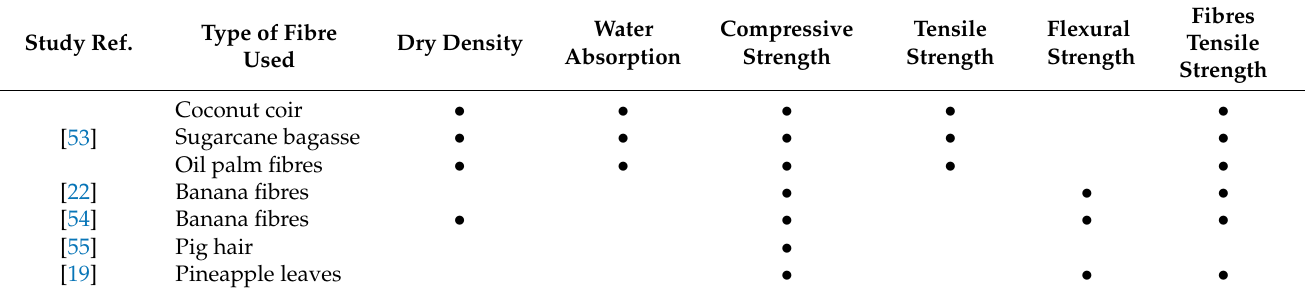
Table 1. Physical and mechanical properties assessed within the literature works considered.